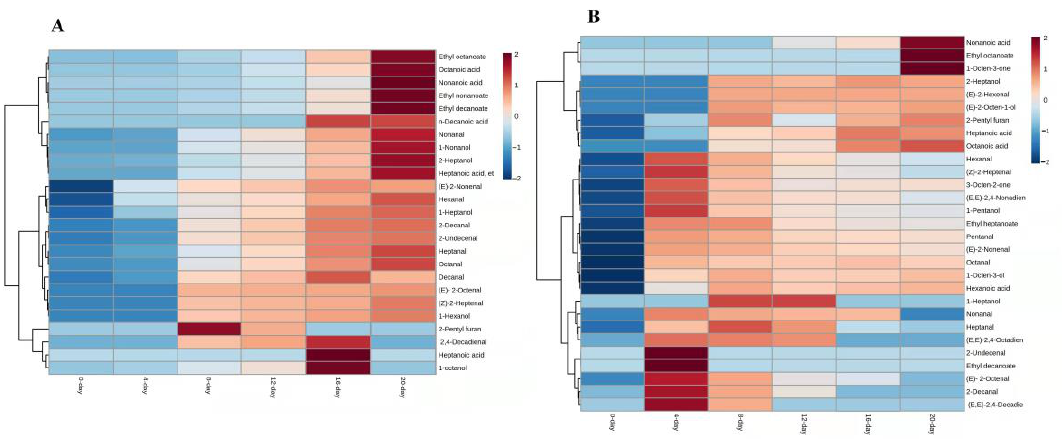
Figure 2. Heatmap visualization of UFAO-derived compounds in model reaction by oleic acid ( A ) and linoleic acid ( B ).